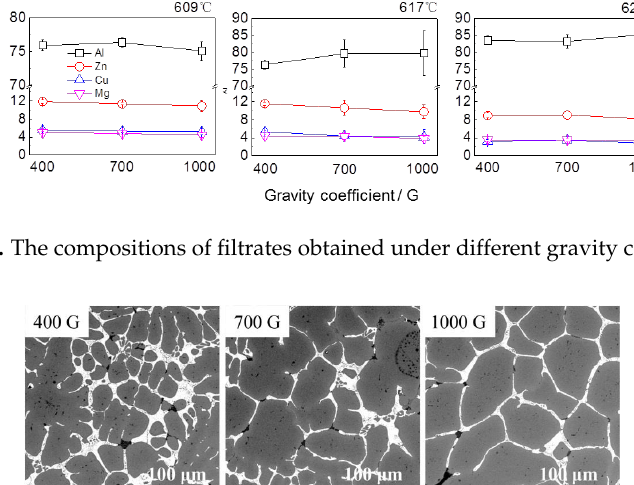
Figure 10. Morphology of layer 1 in the filtrate part (625 °C, backscattered electron mode (BSE)).